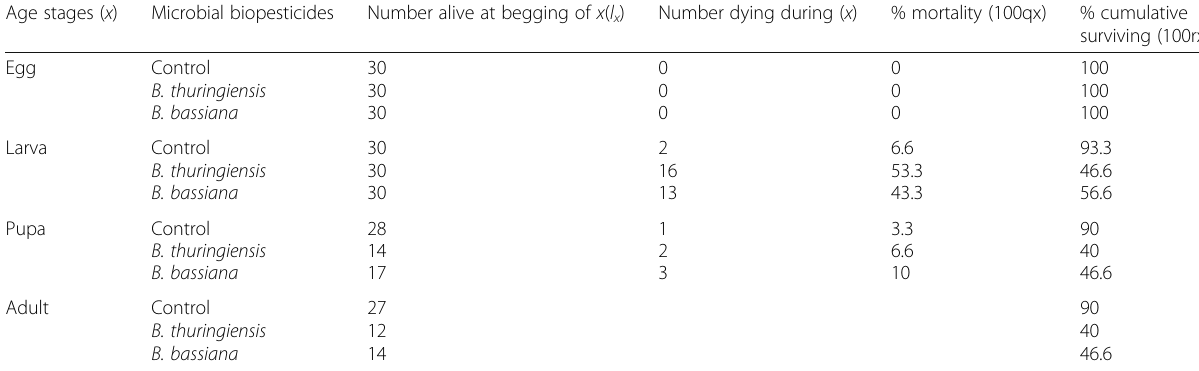
Table 3 Age-specific mortality of T. absoluta treated with the two tested microbial pesticides Age stages ( x )